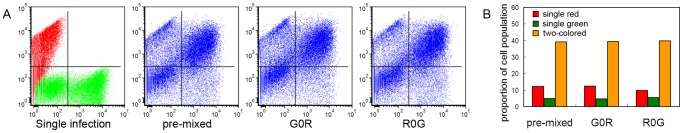
Comparison of cell infection using pre-mixed vAcBacGFP and vAcBacDsRed with infections using sequentially added viruses.A. Flow cytometry data for protein expression at 2 days post infection. Single infection: Sf9 cells were infected individually with vAcBacGFP and vAcBacDsRed then mixed and used as the reference to gate the two-colored and single-colored cell subsets; Pre-mixed: vAcBacGFP and vAcBacDsRed viruses were mixed at a ration of 1∶1, stored at 4°C for 1 day and then used to infect Sf9 cells; G0R: 1 MOI of vAcBacDsRed was applied to Sf9 cell monolayer, mixed well and held for 1 min, before adding 1 MOI of vAcBacGFP; R0G: 1 MOI of vAcBacGFP was applied to Sf9 cell monolayer, mixed well and held for 1 min, before adding 1 MOI of vAcBacDsRed. B. Comparison of the fluorescent cell populations. Bars reflect the flow cytometry data shown in A.